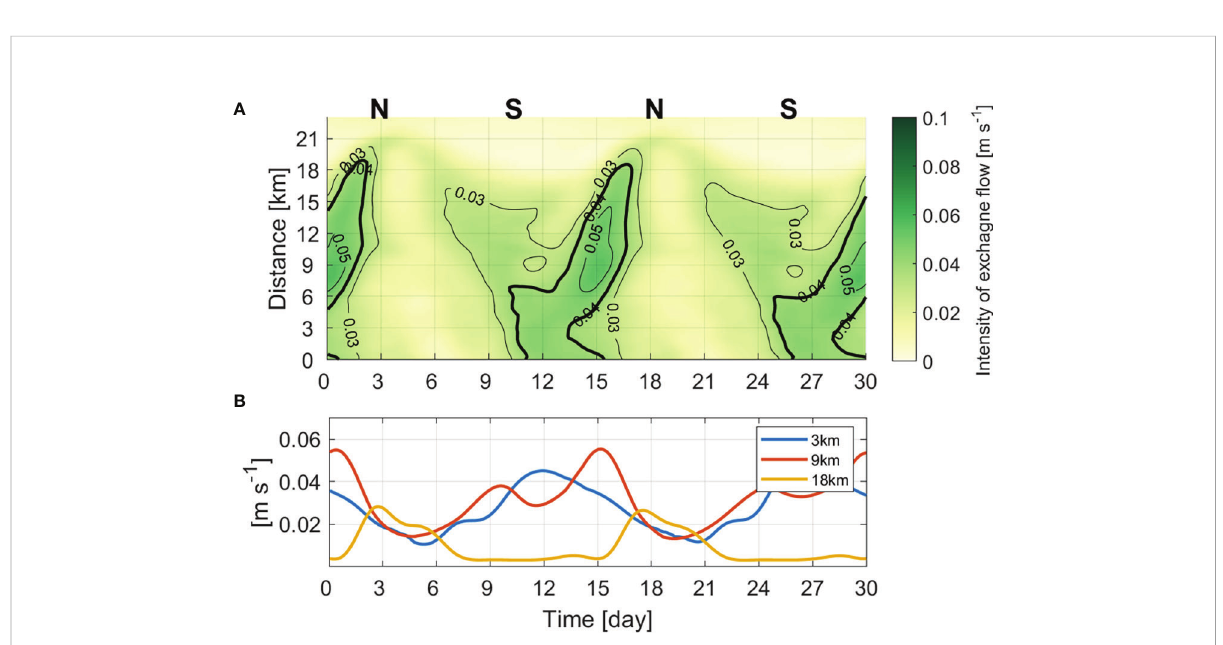
FIGURE 8 (A) Hovmöller diagram of the depth-averaged absolute value of the exchange fl ow and (B) timeseries of the intensity of the exchange fl ow at 3, 9, and 18 km from the estuary mouth (unit: ms -1